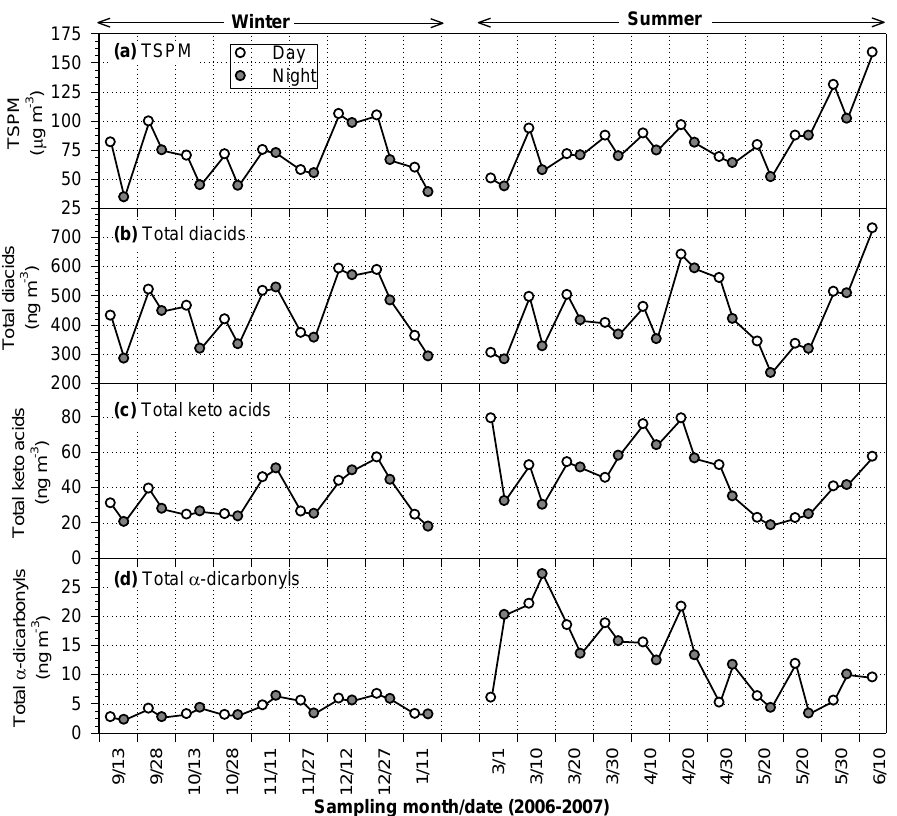
Fig. 3. Temporal variations in total suspended particulate matter (TSPM) along with mass fraction of total diacids, total ketoacids, and total α -dicarbonyls in TSPM for aerosol samples collected at Nainital,